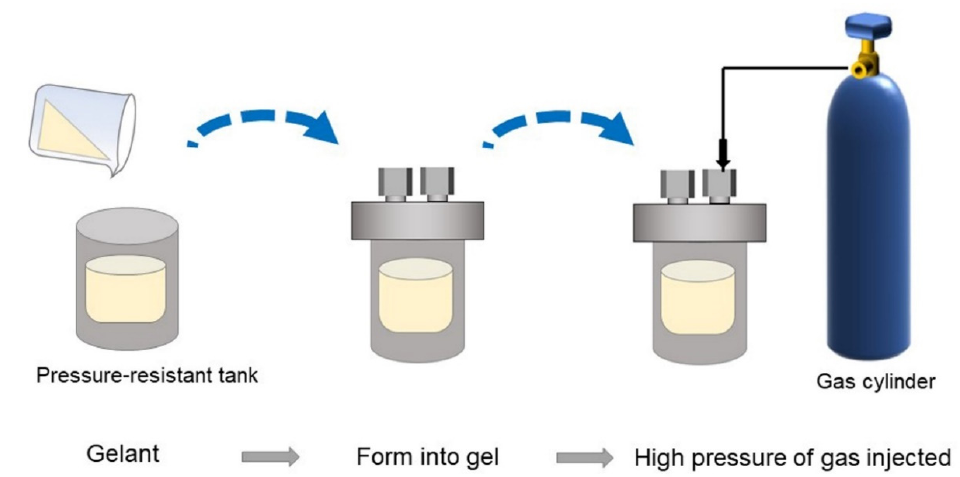
Figure 16. Experimental flow for investigating long-term stability of gels at elevated gas pressures.